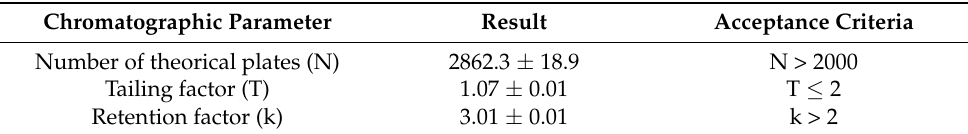
Table 3. System suitability of the HPLC method ( n = 6).